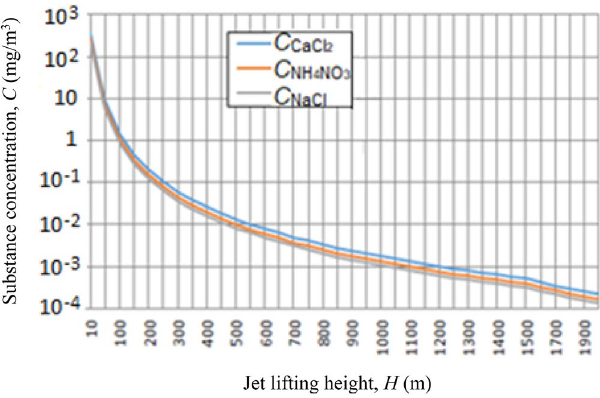
Figure 19. Dependence of hygroscopic aerosol concentration C from